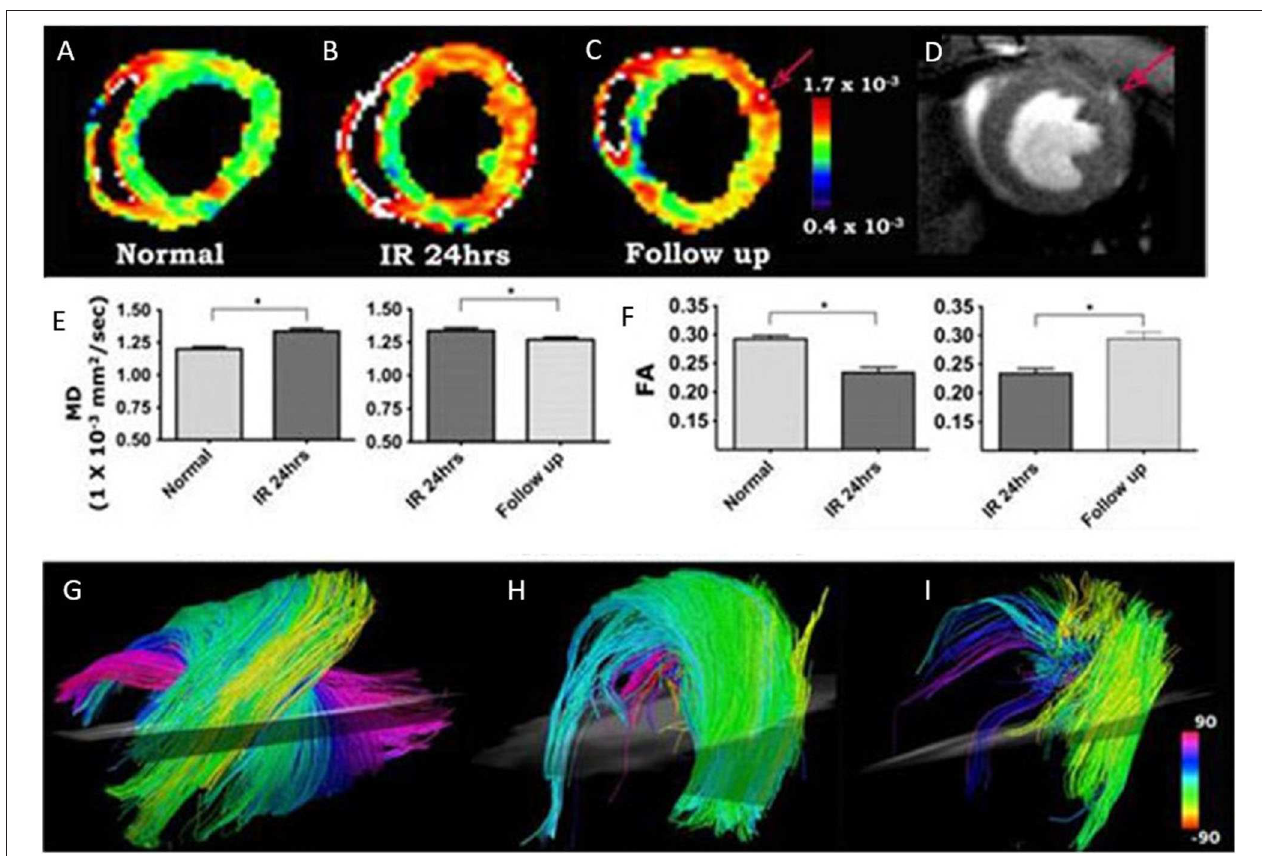
FIGURE 12 | (A–I) In vivo DTI-tractography of mouse heart at baseline, 24h after injury and 2–3 weeks after ischemia-reperfusion. The mean diffusivity (MD) maps clearly showed that MD in the injured anterolateral wall increased acutely (24h after injury) and subsequently returned toward baseline as the myocardium healed (A–C,E) . Fractional anisotropy (FA) decreased acutely and returned to baseline 2–3 weeks after injury (F) . (C,D) The left coronary artery, when present in the image, can be used for internal standardization and control. MD in the vessel and its branches (red arrow, C,D ) will be significantly higher than MD in normal or healing myocardium. Myofibers passing through a region of interest placed in the anterolateral wall are shown in (G–I) . (G) Normal mouse heart. The characteristic arrangement of myofibers into an array of crossing helices is clearly visible. (H) Mouse exposed to ischemia-reperfusion with severe hypokinesis in the anterolateral wall. However, MD has remained < 1.3 × 10 × mm 2 /s and fiber architecture remains reasonably organized. (I) Mouse exposed to ischemia-reperfusion, also presenting with severe hypokinesis of the anterolateral wall. MD in this mouse, however, is < 1.3 × 10 − 3 mm 2 /s and fiber architecture is severely perturbed. Reproduced with permission from Huang et al. [